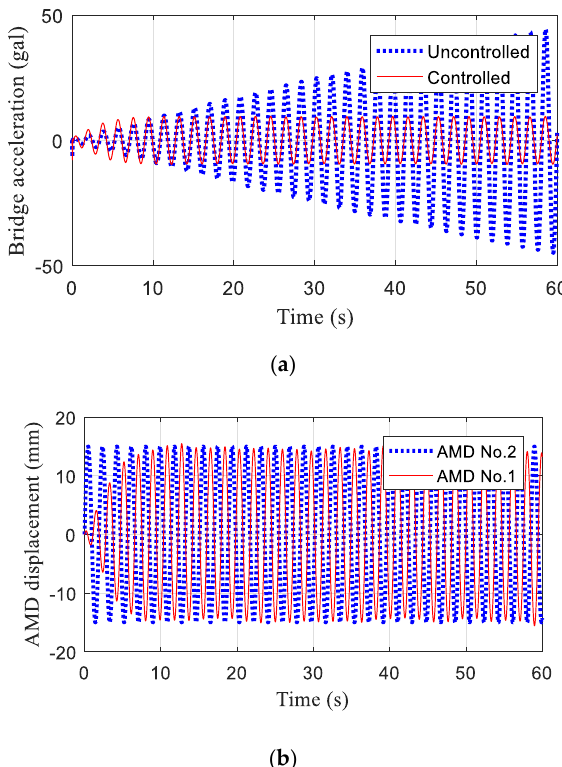
Figure 12. Control results for a constant external force through simulation: ( a ) acceleration of the bridge model and ( b ) displacement of the vibrator and AMD.